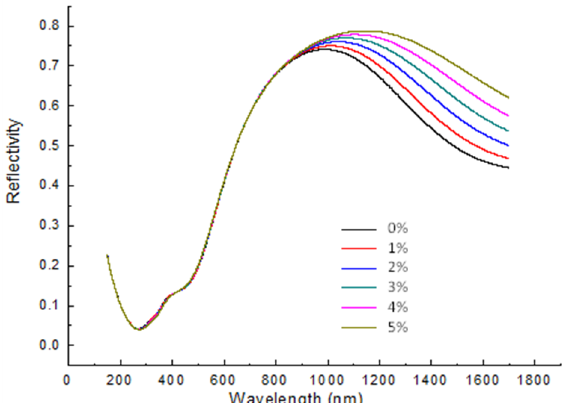
Figure 3. Numerical reflectivity calculations at various wavelengths of 49.7° oblique incident light for various glucose solution concentrations. The thickness of the deposited TiN layer is 46 nm.